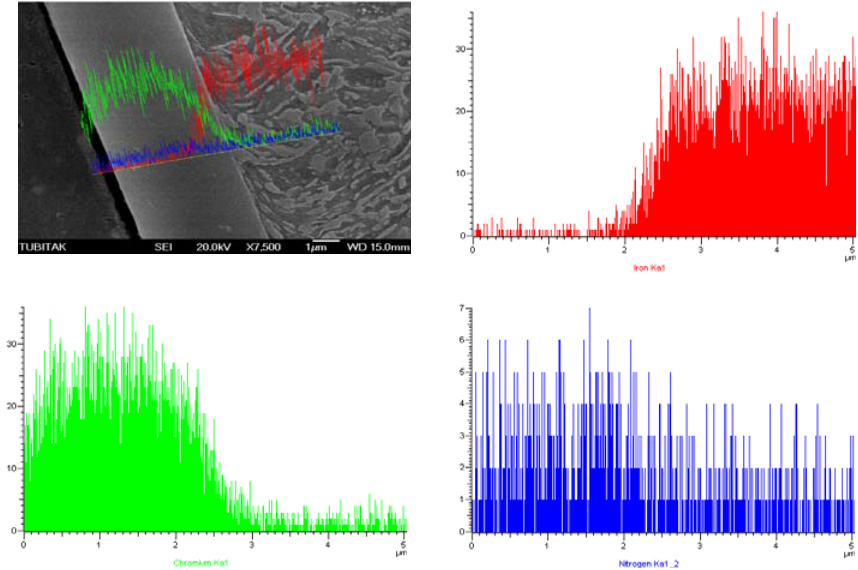
Figure 9 . EDS line-scan analysis of CrN-coated